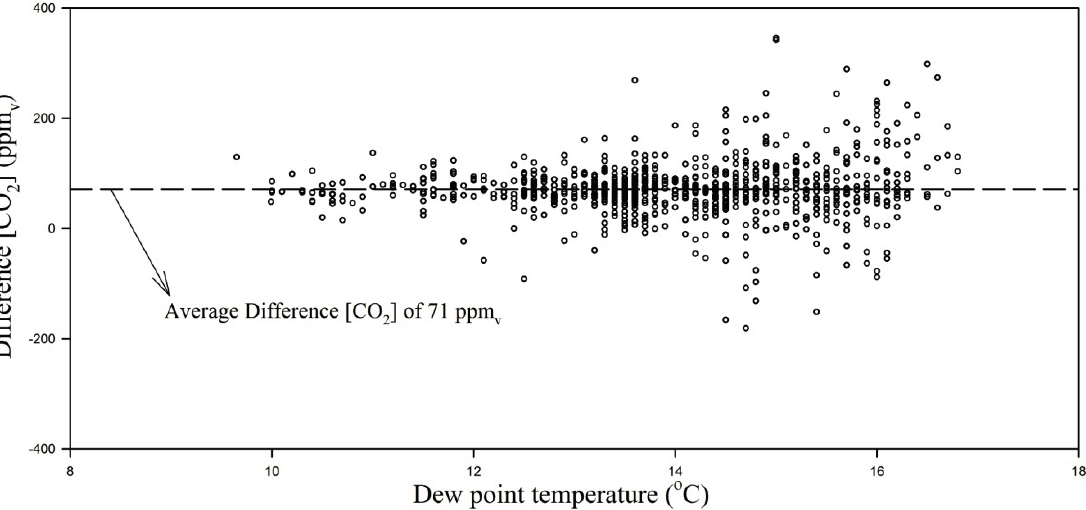
Figure 10. Plot representing the increased absolute difference between PAS and NDIR measurements of CO 2 concentrations (ppm v ) in the dairy cow house with increasing dew-point temperature (T dp ,